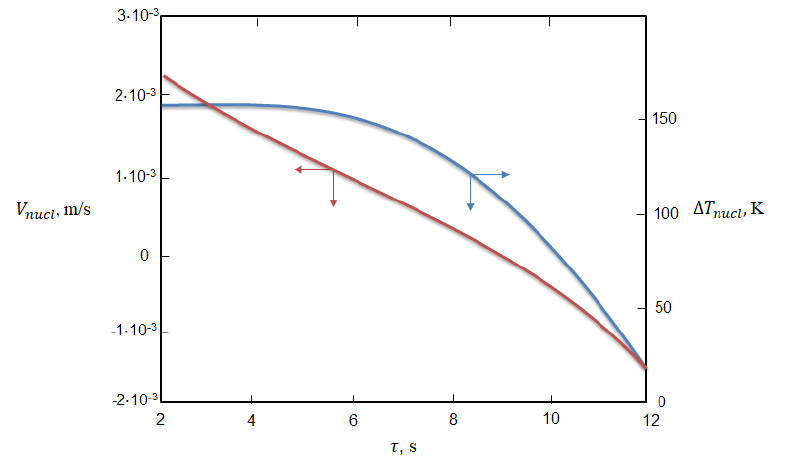
Figure 3. The bulk crystallization velocity V nucl (red line) and melt undercooling ∆ T nucl (blue line) as functions of time τ for pure nucleation mode. Physical parameters used for calculations are: ∆ T = 400 K, I = 10 11 m − 3 s − 1 , β ∗ = 2 · 10 − 7 m s − 1 K − 1 , τ 0 0 β = 0.1, k = 1, γ = 3 · 10 3 , p =